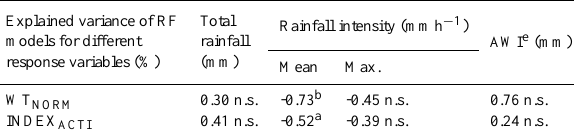
Table 6. Correlation coefficients highlighting the effect of rainfall characteristics and antecedent wetness on RF model performance. Displayed are linear correlation coefficients between RF model per- formance for the response variables WT NORM and INDEX ACTI and different rainfall characteristics and antecedent wetness. For model performance per temporal scale see Fig. 4, top graph; for rainfall characteristics and antecedent wetness per temporal scale see Fig. 2 and Table 2. Correlation with total rainfall n = 12 (all temporal scales), correlation with rainfall intensity n = 11 (seasonal and event scale), correlation with AWI n = 5 (event scale only).